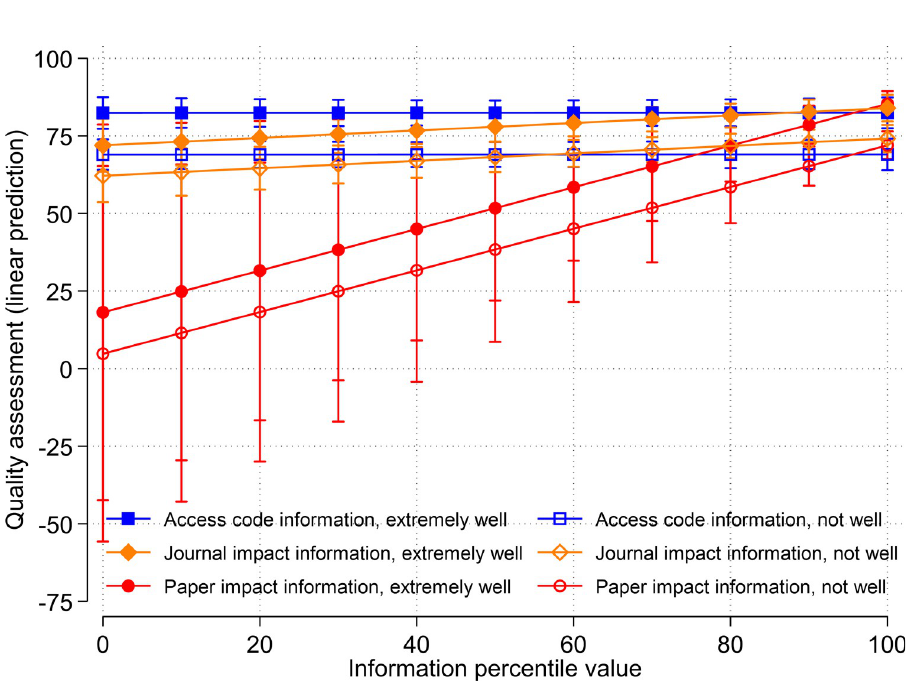
Fig 6. Relationship between treatments (access code information, journal impact information, and paper impact information) and quality assessments for respondents with extremely good knowledge (solid symbols) and poor knowledge (hollow symbols) of the cited